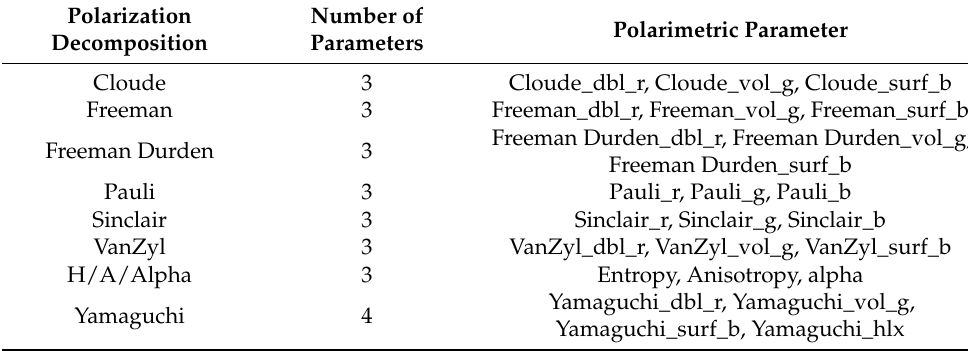
Table 5. Polarimetric features extracted from the PALSAR-2